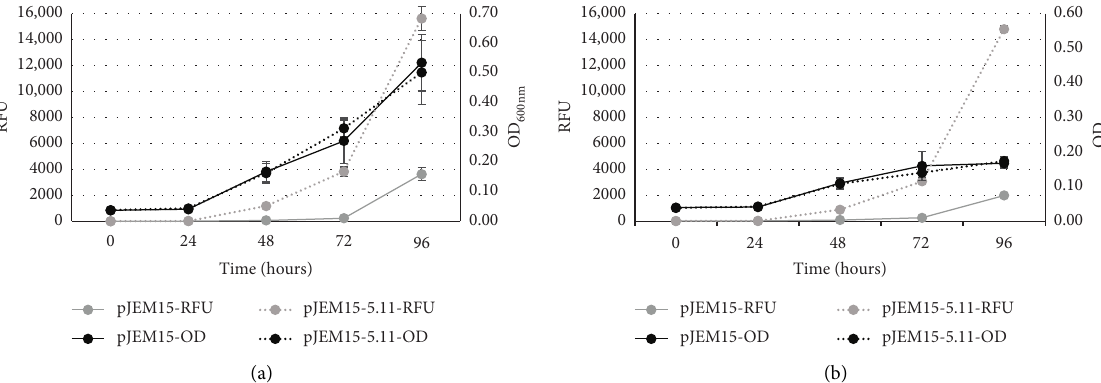
Figure 4: Promoter activity of the putative operon mfp EA operon in different growth conditions. (a) 7H9 (pH 8.0). (b) 7H9 with ciprofloxacin (0.125 μ g/ml). Curves labelled OD represent mycobacterial growth, while the RFU curves indicate beta-galactosidase activity. Table 3: Effect of mfp A overexpression on ciprofloxacin MIC.